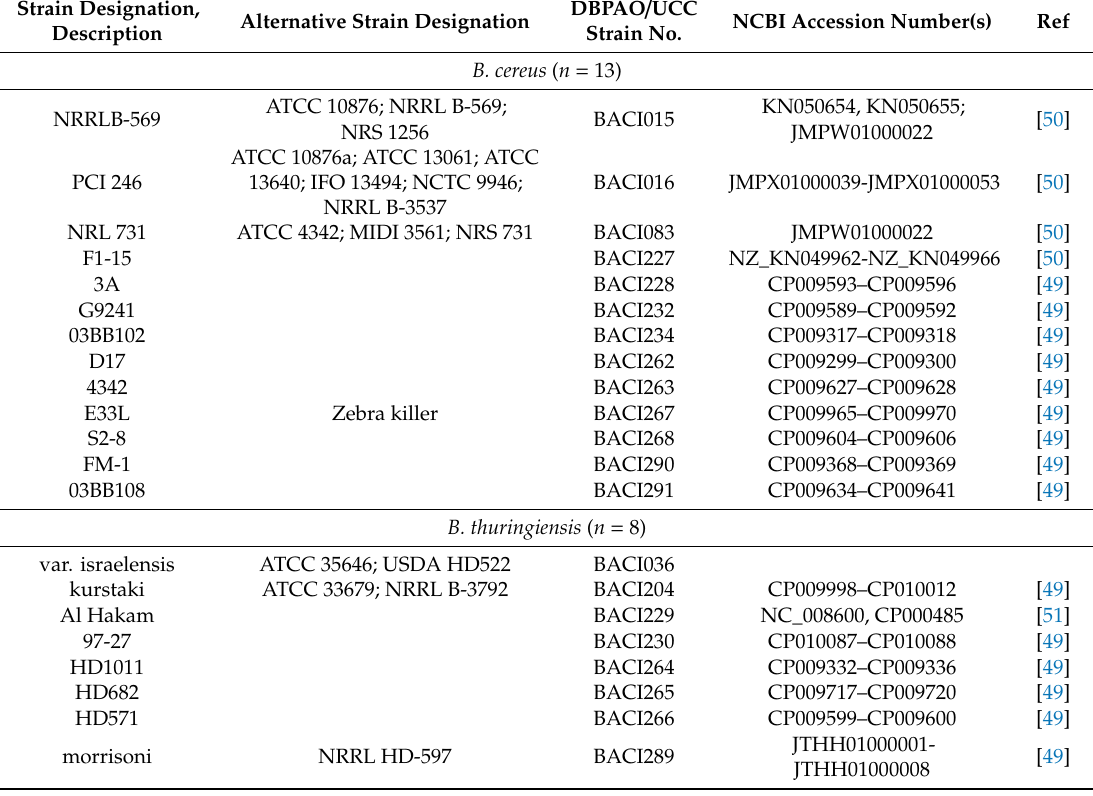
Table 13. B. cereus and B. thuringiensis strains used in this